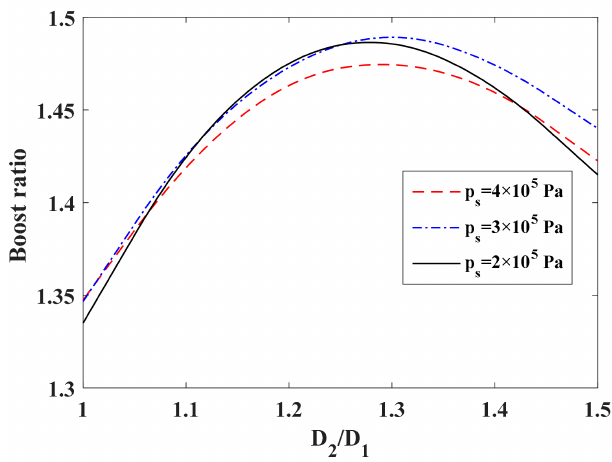
Figure 15. Relationship between boost ratio and diameter